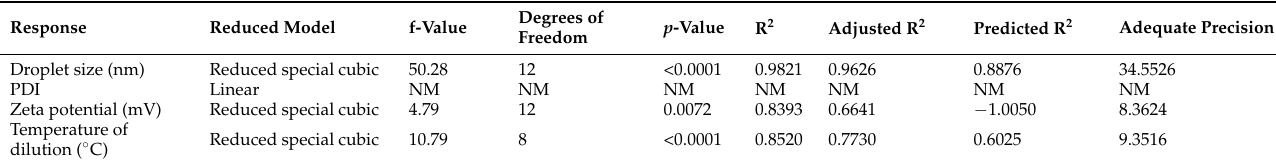
Table 5. Analysis of variance of the modified models.